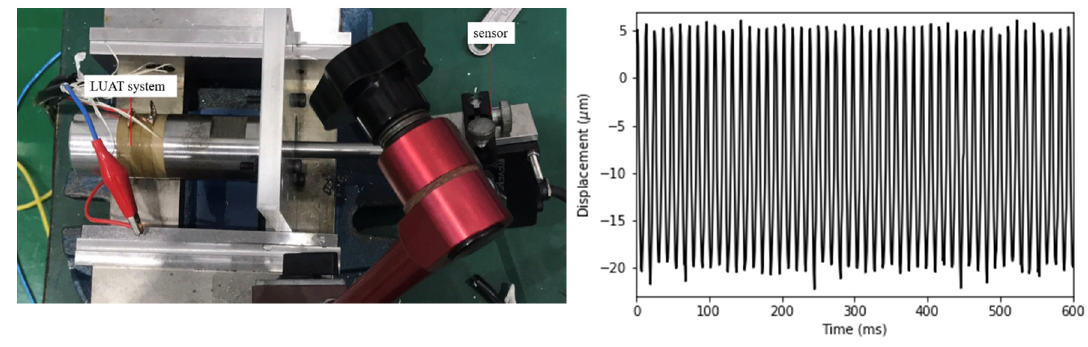
Figure 6. Displacement testing experiment. ( a ) longitudinal ultrasonic assisted turning (LUAT) system; ( b ) layout of displacement testing experiment; ( c ) laser displacement sensor; ( d ) displacement of LUAT.